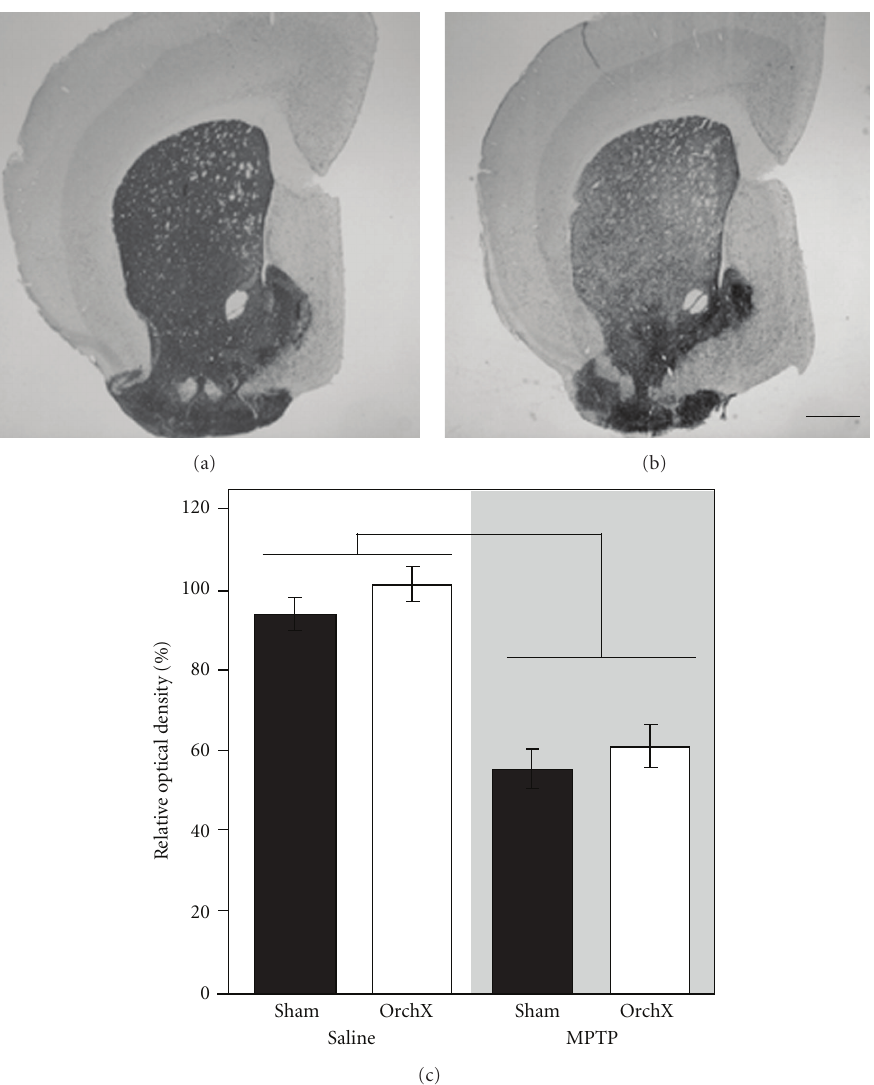
Figure 1: TH staining in the dorsolateral striatum. Photomicrographs of TH staining in gonad-intact saline-injected (a) and MPTP-treated (b) mice. Scale bar = 500 μ m. (c) The density of TH staining in the dorsolateral striatum of saline-injected (clear) and MPTP-treated (shaded) gonad-intact (black bars) and orchidectomized (white bars) male mice ( n = 8–10 mice/group). The bar represents an e ff ect of MPTP ( P < . 05). OrchX: orchidectomized; Sham: